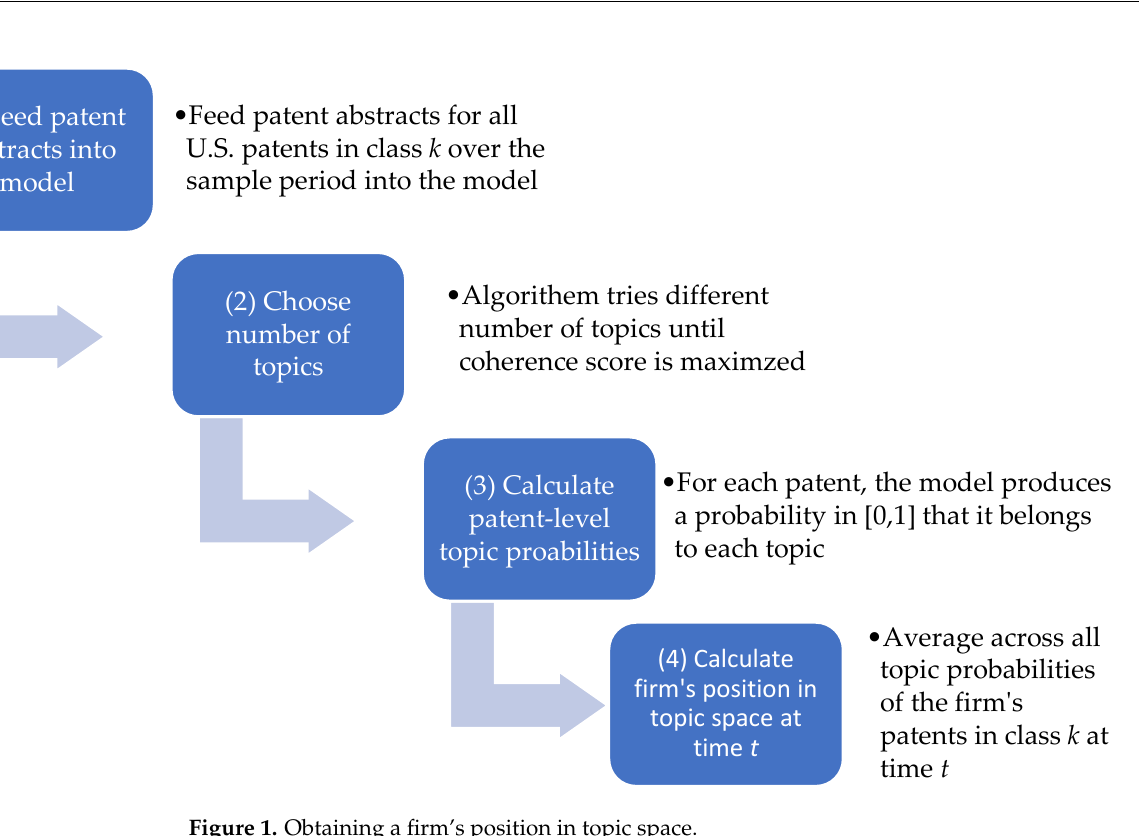
Figure 1. Obtaining a firm’s position in topic space.